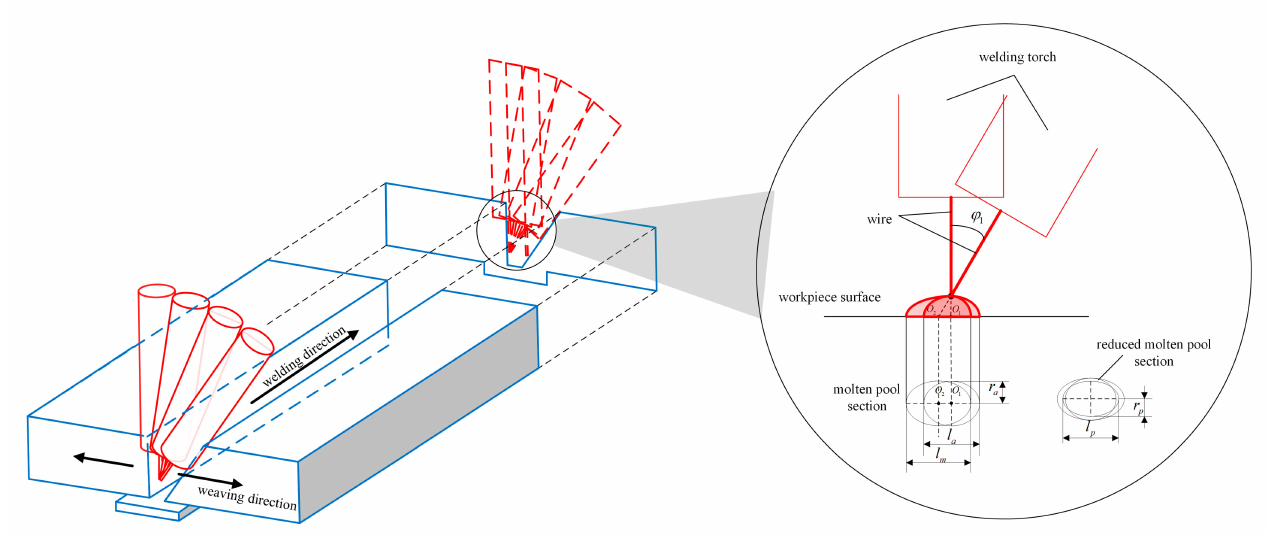
Figure 2. Welding heat-input variation caused by inclination